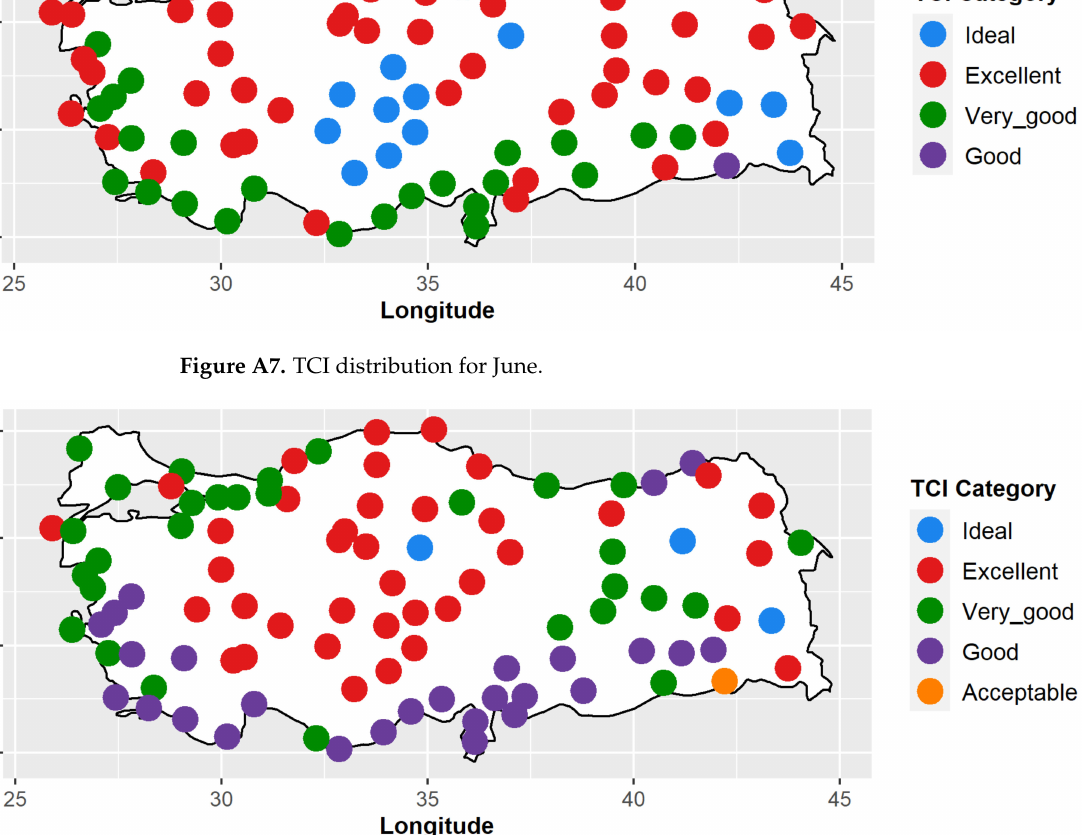
Figure A8. TCI distribution for